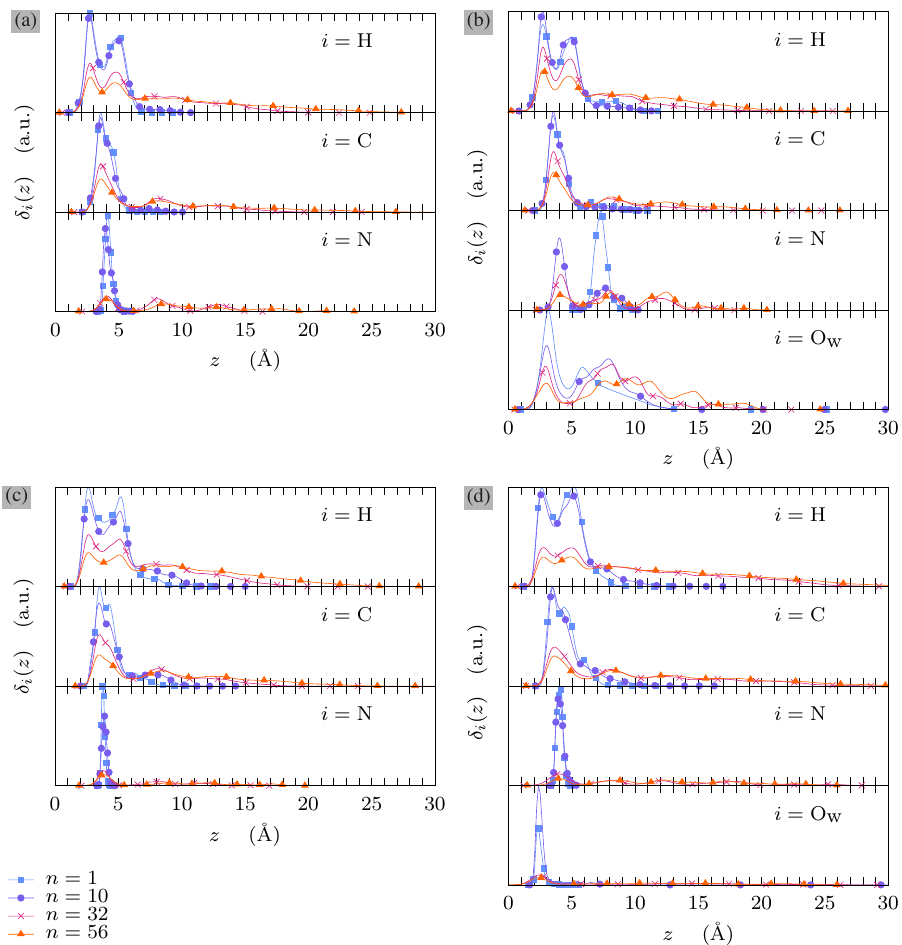
Figure 1. One-dimensional density profiles δ i ( z ) of i -th atom type (with i denoting H, C, N and O w atoms, respectively). Four different setups are shown, corresponding to the hydrophobic siloxane surface without ( a ) and with ( b ) residual water molecules and to the hydrophilic alumina surface without ( c ) and with ( d ) residual water molecules, respectively. The displayed lines correspond to surface loading of n = 1 (ultramarine squares), 10 (indigo circles), 32 (magenta crosses) and 56 (orange triangles) POPC molecules per given kaolinite surface. The value z denotes the distance of the i -th atom type from the kaolinite basal